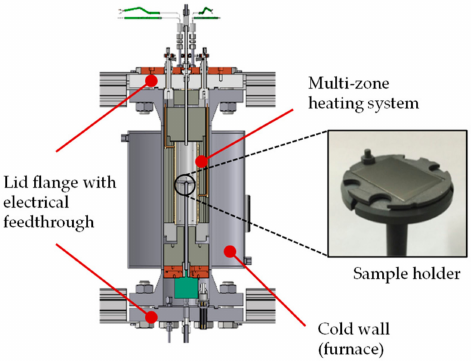
Figure 4. Structural design of the high-pressure autoclaves and design of the sample